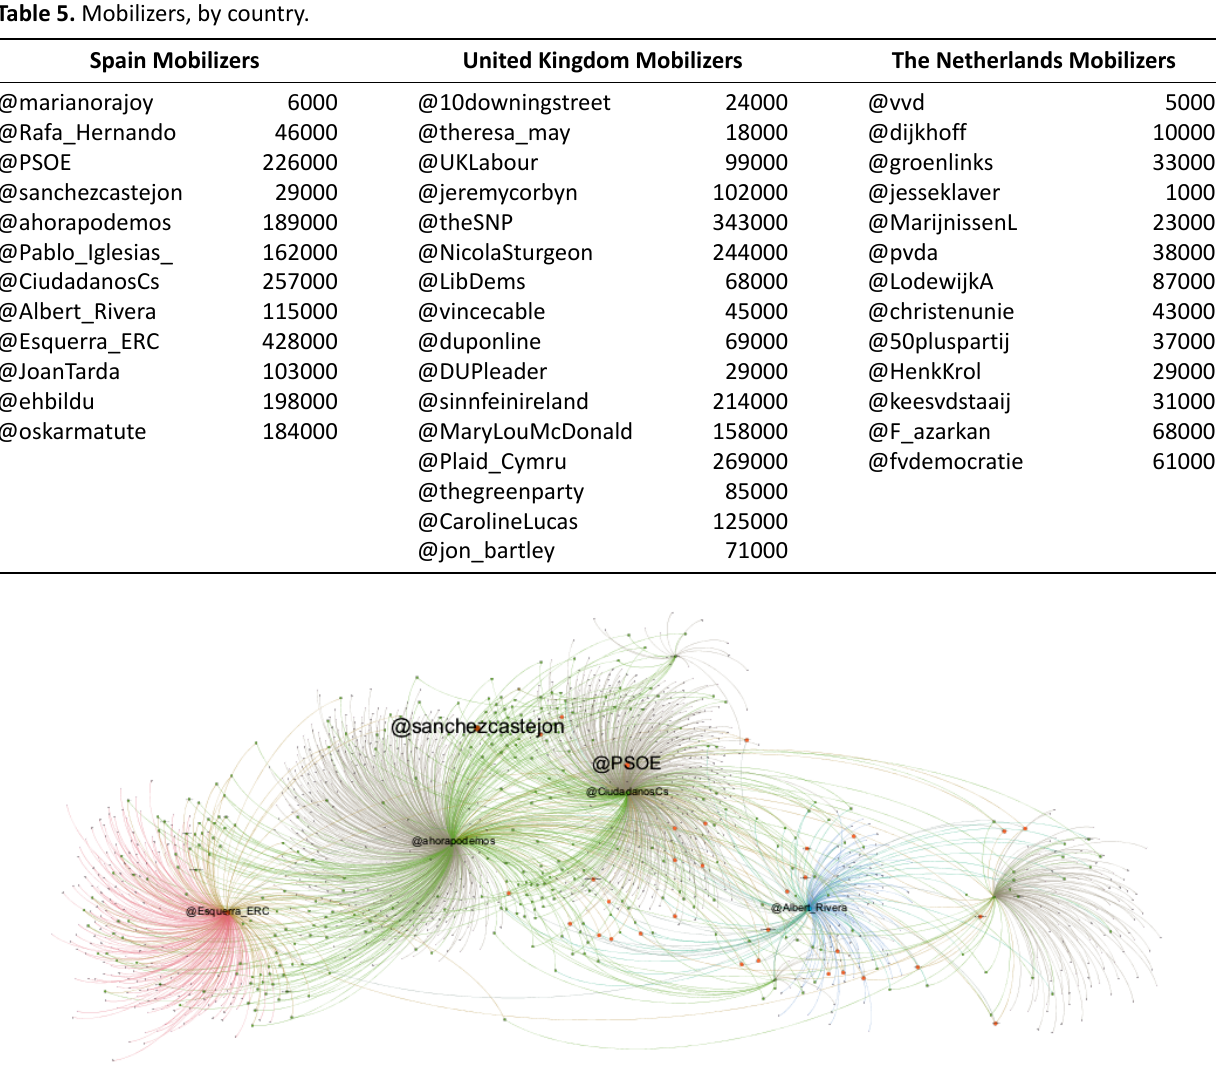
Figure 1. Twitter network, Spanish